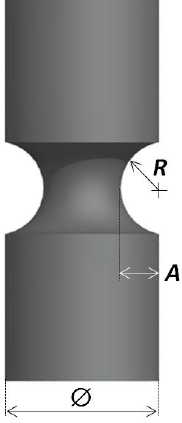
Figure 2. Round notched geometry used in the tests.